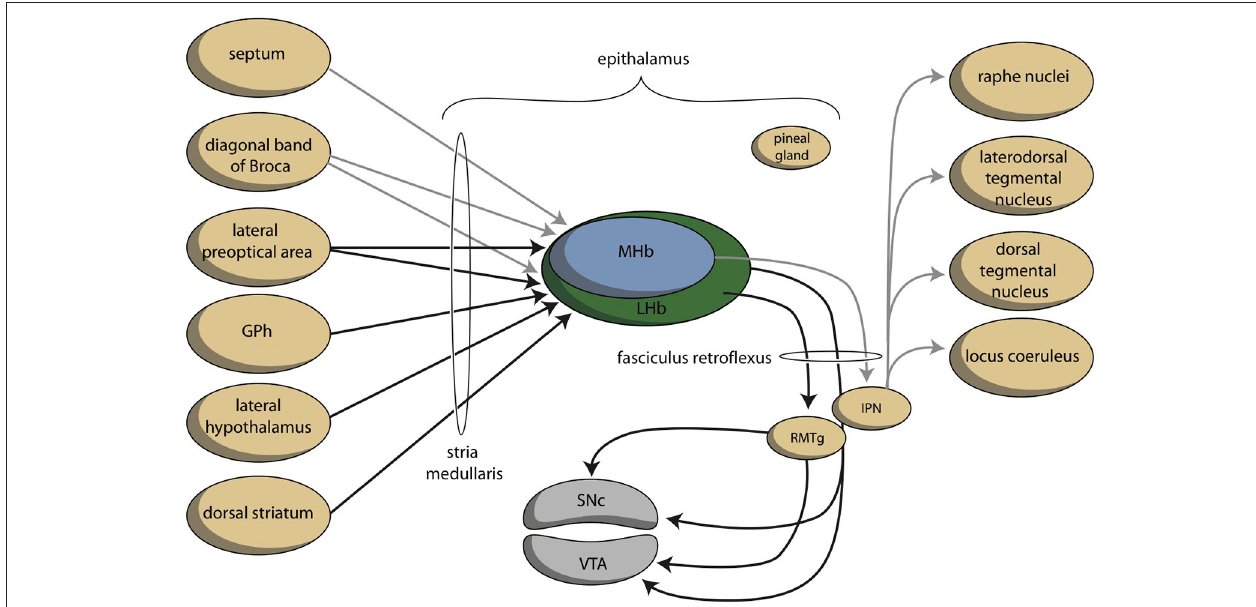
FIGURE 6 | Simplified representation of the connectivity through the epithalamus (adapted from Hikosaka, 2010). GPh, habenula-projecting globus pallidus; IPN, interpeduncular nucleus; RMTg, rostromedial tegmental nucleus; SNc, substantia nigra, pars compacta; VTA, ventral tegmental area. GPh depends upon the cortical-subcortical circuit being considered. GPh, localized within the bed nucleus of the stria terminalis in the limbic circuit, within the ventral pallidum concerning the motivational circuit and within the globus pallidus (border region, GPb) within the extrapyramidal circuit.